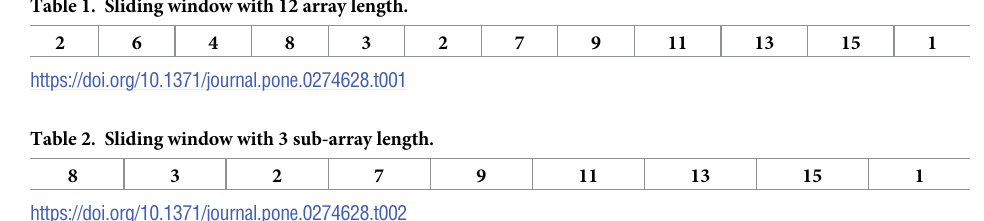
Table 1. Sliding window with 12 array